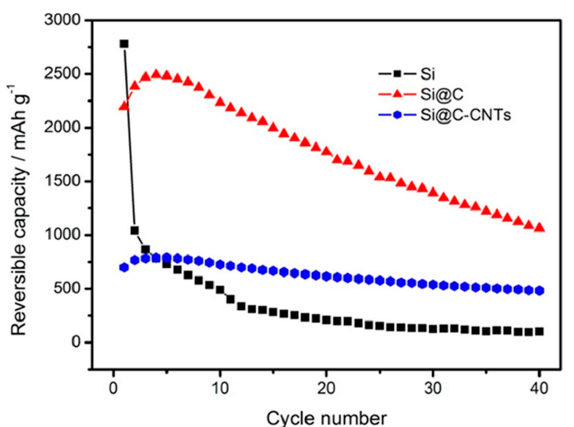
Figure 11. Cycling performance of Si, Si@C, and Si@C–CNTs at 100 mA g − 1 in a 0.02–2.0 V voltage window. Reproduced with permission from [137]. Copyright ACS, 2012.